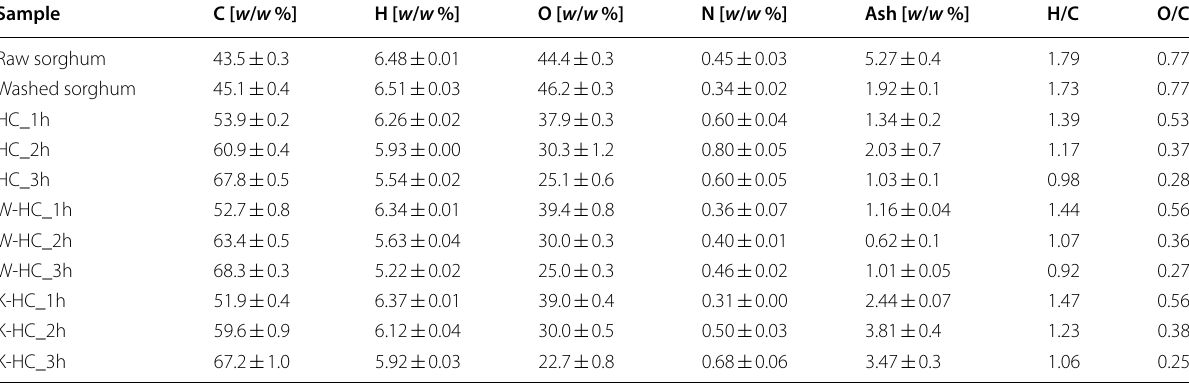
Table 1 Elemental analysis (dry basis) and ash of raw material and hydrochar Sample C [ w / w %]